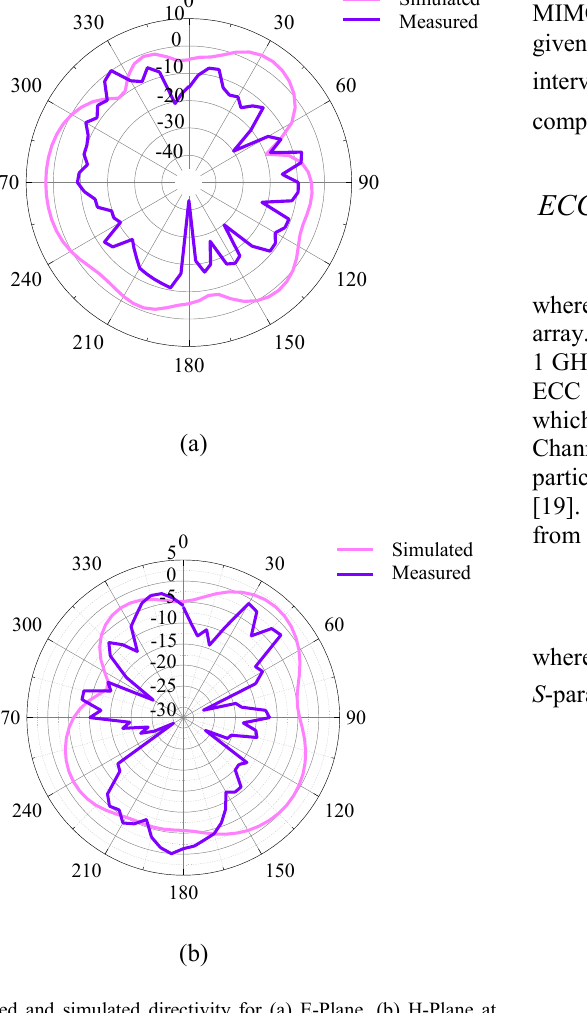
Fig. 10. Measured and simulated directivity for (a) E-Plane, (b) H-Plane at 10.6